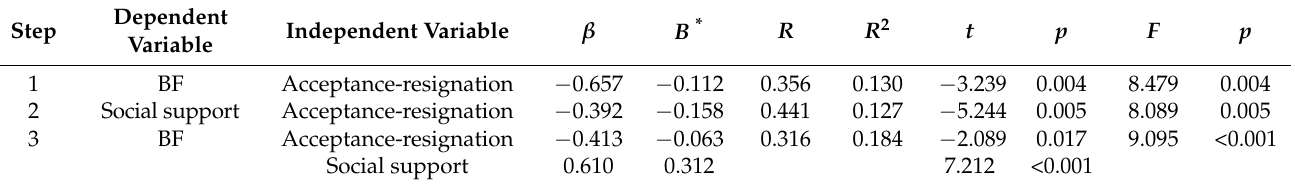
Table 6. Verification of mediating effect of social support on acceptance-resignation dimension and